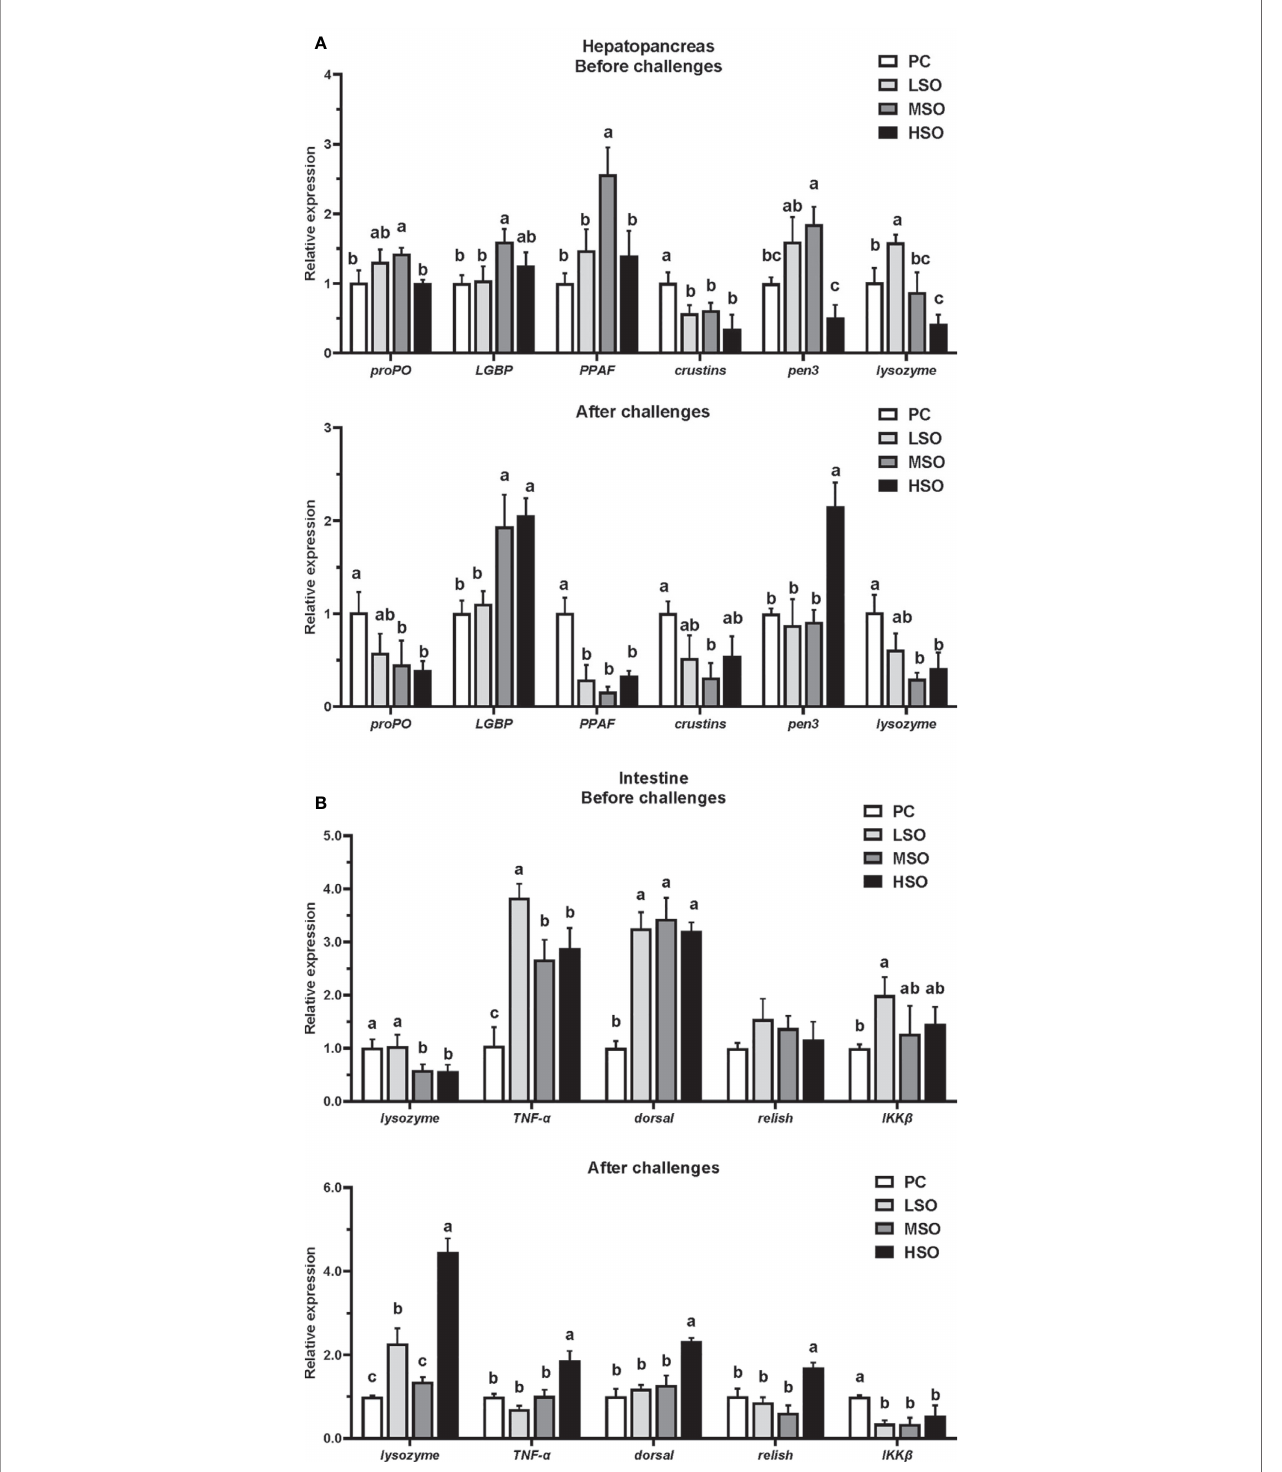
FIGURE 2 | Immune-related gene mRNA relative expression (A) in hepatopancreas of shrimp in this study; (B) in intestine of shrimp in this study. Note: Vertical bars represent the mean ± SD ( n = 3). Data marked with different letters differ signi fi cantly ( p < 0.05) among groups based on Tukey ’ s multiple test. proPO , prophenoloxidase; LGBP , Beta-1,3-glucan-binding Protein; PPAF , prophenoloxidase activating factor; Pen3 , penaeidins3. TNF- a , tumor necrosis factor- a ; IKK b , inhibitor of nuclear factor kappa-B kinase b